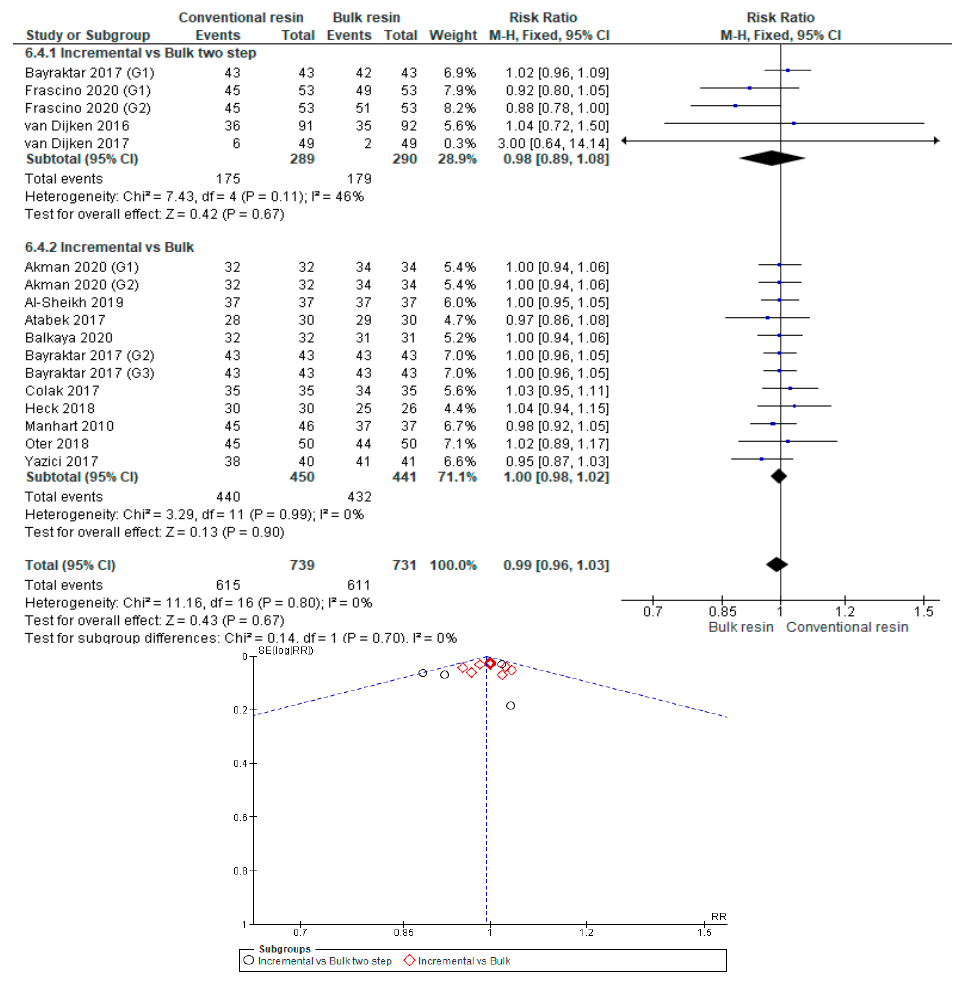
Figure A28. Adequate Color Stability and Translucency: Conventional Resin versus Bulk Resin According to Type of Teething.